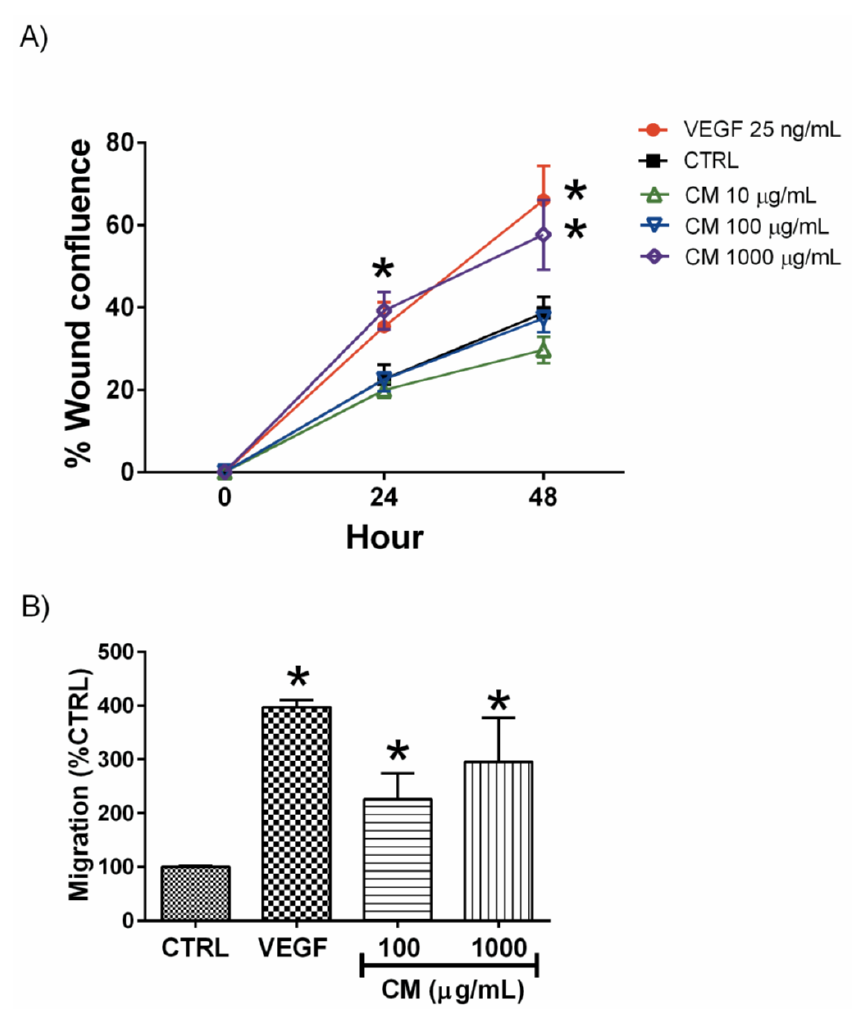
Figure 3. Effects of CM on endothelial wound closure and cell migration. ( A ) Percentage of wound confluence indicating the rate of endothelial wound closure at 24 and 48 h when comparing CM treatment with vehicle treated cells (CTRL); ( B ) Endothelial cell migration using Boyden chamber assay as described in Material and Methods. * p < 0.05 vs.